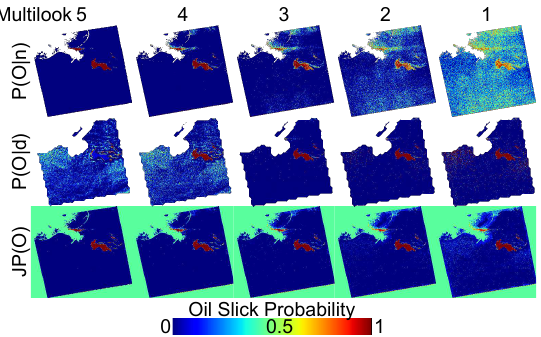
Figure 4: Results for the first (point probability) and second